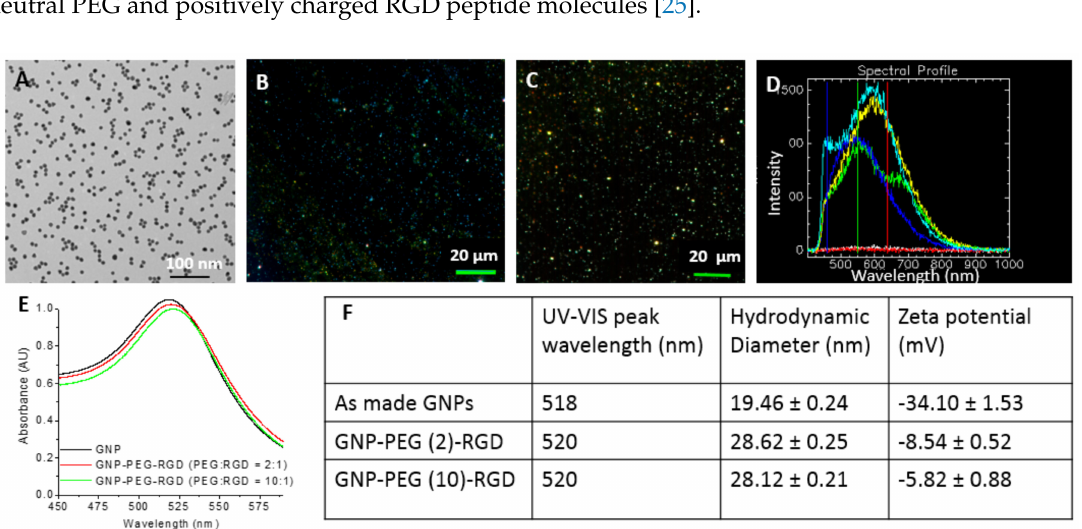
Figure 2. Characterization of GNPs used in this study: ( A ) Transmission Electron Microscopy (TEM) of GNPs used in this study. Scale bar = 100 nm; ( B ) Dark field image of GNPs. Scale bar = 20 µ m; ( C ) Hyperspectral image of GNPs; ( D ) A few spectra of the GNPs from ( C ) and background spectra; ( E ) Ultraviolet-Visible (UV-VIS) spectra of GNP constructs; ( F ) Peak wavelength, hydrodynamic diameter, and zeta potential of GNP constructs used in this